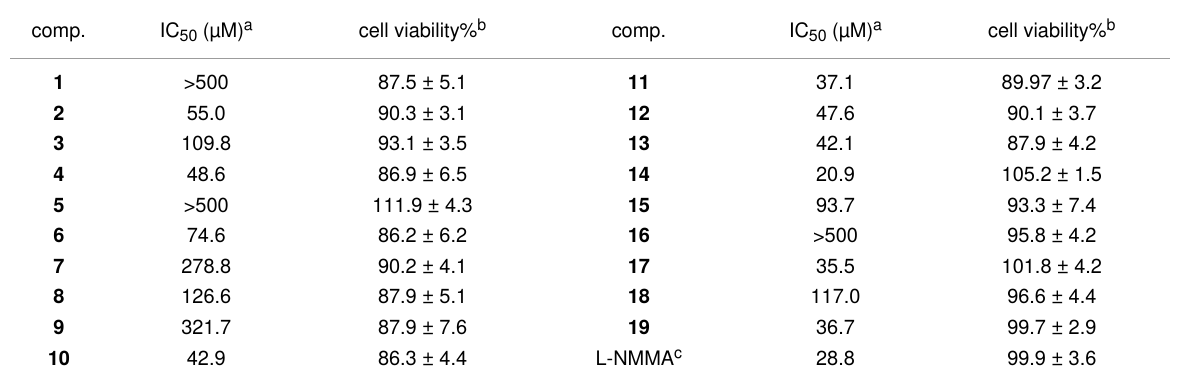
Table 3: Effects of isolated compounds on NO production in LPS-activated BV-2 cells. comp.